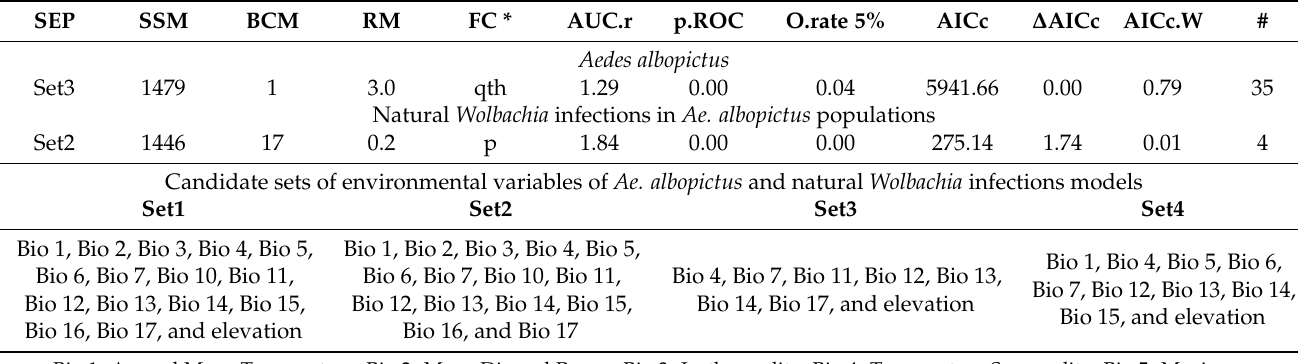
Bio 1: Annual Mean Temperature; Bio 2: Mean Diurnal Range; Bio 3: Isothermality; Bio 4: Temperature Seasonality; Bio 5: Maximum Temperature of Warmest Month; Bio 6: Minimum Temperature of Coldest Month; Bio 7: Temperature Annual Range; Bio10: Mean Temperature of Warmest Quarter; Bio11: Mean Temperature of Coldest Quarter; Bio12: Annual Precipitation; Bio13: Precipitation of Wettest Month; Bio14: Precipitation of Driest Month; Bio15: Precipitation Seasonality; Bio16: Precipitation of Wettest Quarter; and Bio17: Precipitation of Driest